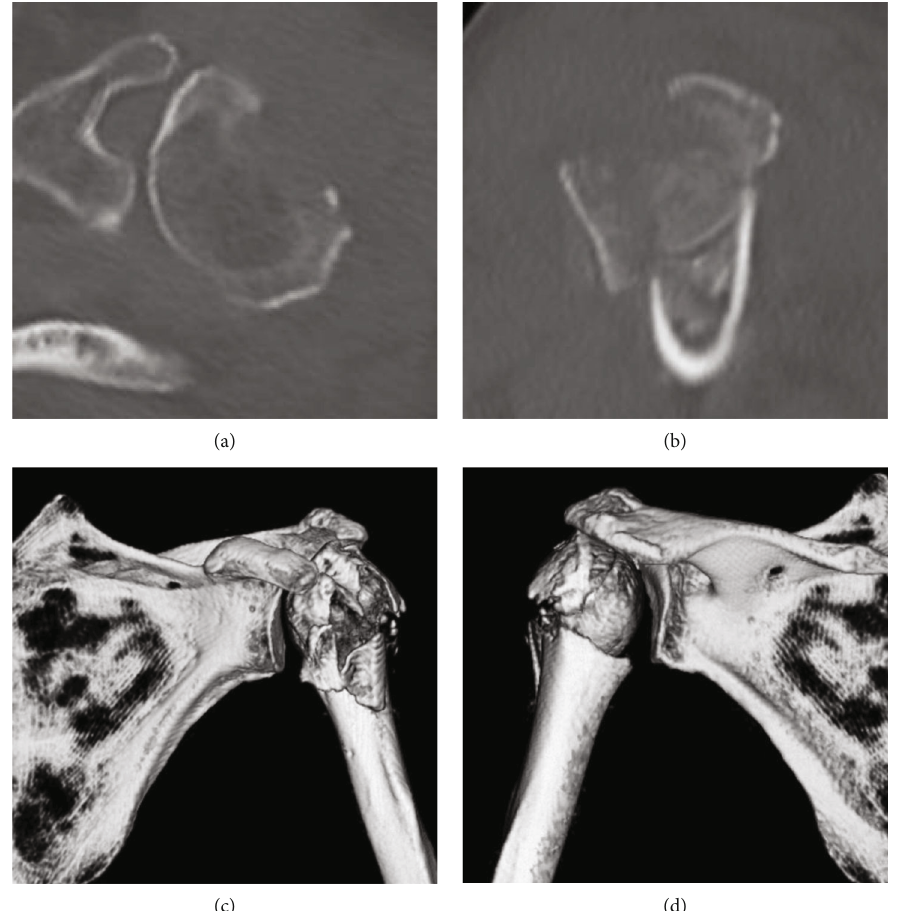
Figure 3: Computed tomography images of the left shoulder showing the three-part fracture of the proximal humerus: (a) axial image, (b) sagittal image, (c) frontal view in a 3D image, and (d) posterior view in a 3D image.